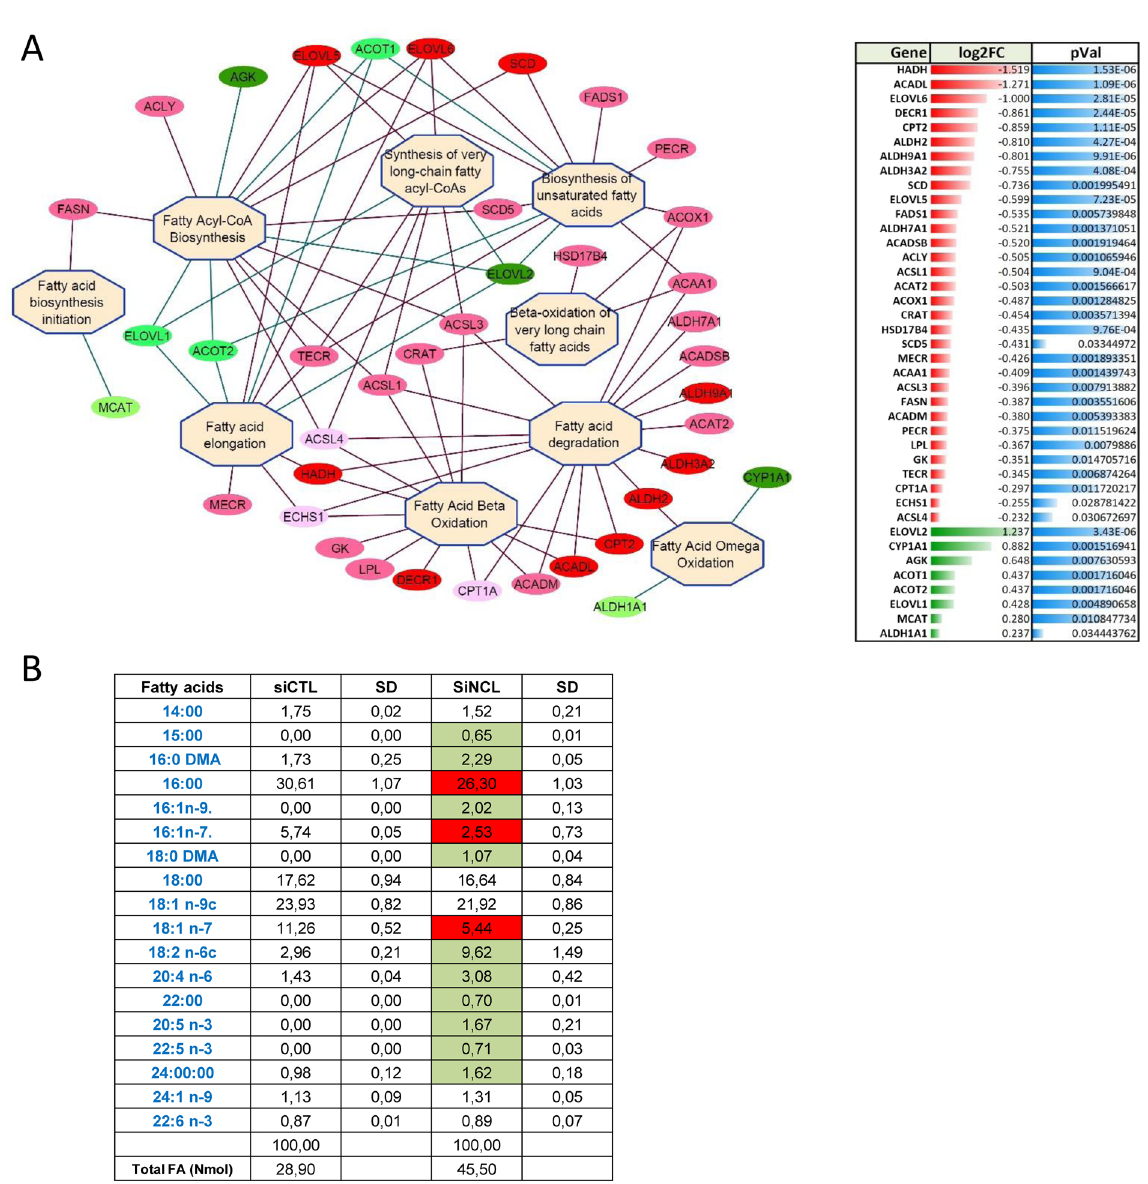
C16:1n-7 and C18:1n-7. C16:1n-7 is probably formed from the pathway involving the Stearoyl-CoA desatu- rase (SCD) that is strongly down-regulated in our study while the global increased of saturated FA and unsatu- rated n-3 and n-6 are likely the consequences of the upregulation of the elongase ELOV1and ELOV2. The strong down-regulation of many of the enzymes involved in FA beta-oxidation or degradation (Fig. 5A) results in a global increased of FA in NCL depleted cells. The transcription factor SREBP1 is involved in the regulation of many of these enzymes that are found down-regulated in our study. As the expression of SREBP1 mRNA is also down-regulated (FC -1.6; Supplementary Table 1) we determined if the level of SREBP1 protein was also down-regulated in cells depleted in NCL. Indeed, western blot analysis (Fig. 6A,B) indicated a good correlation between the decreased level of expression observed in the transcriptomic data and the level of accumulation of the SREBP1 protein. The nuclear transcriptional activity of SREB1 is also regulated by its translocation from the membrane of the endoplasmic reticulum to the